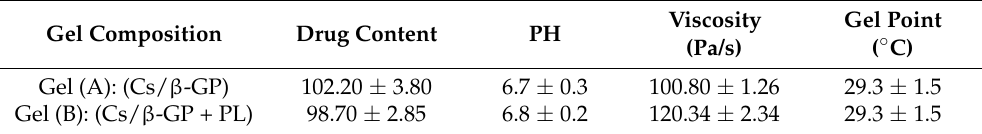
Table 1. Physicochemical properties of the modified hydrogel systems. Gel Composition Drug